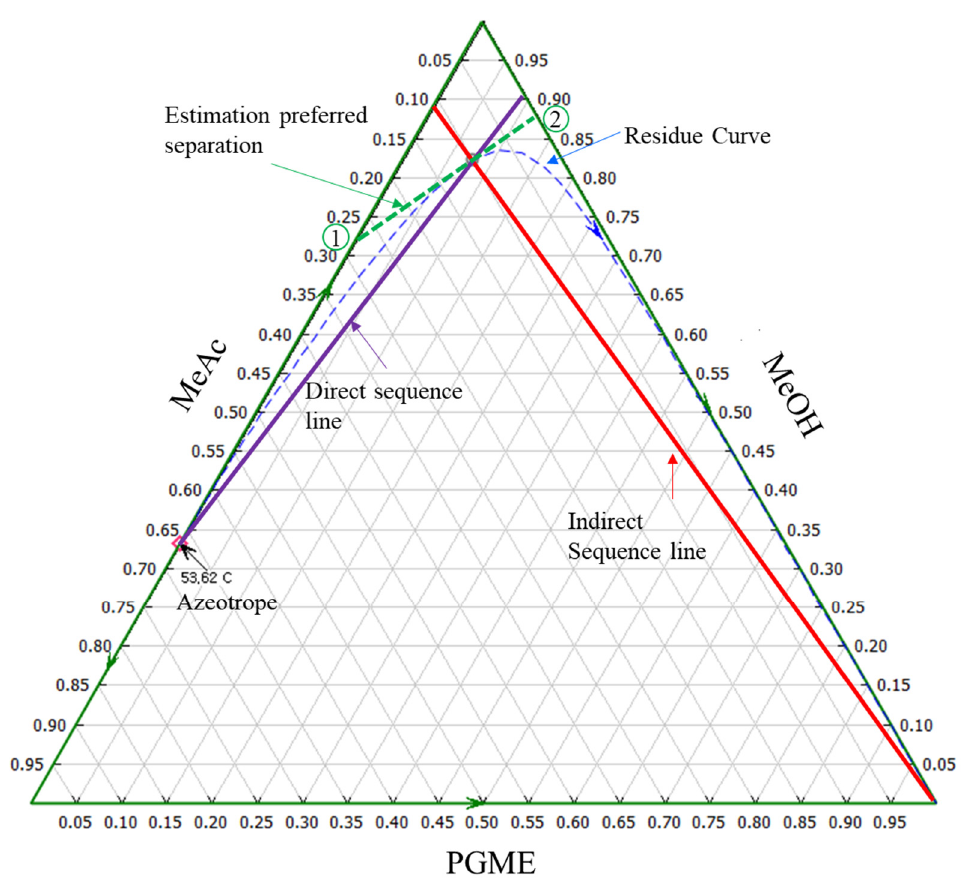
Figure 5. Estimation of lever rule inside feasible separation region for designing prefractionator. The estimation value is Point 1. MeAc = 0.28 and MeOH = 0.72. Point 2. MeOH = 0.85 and PGME = 0.15.